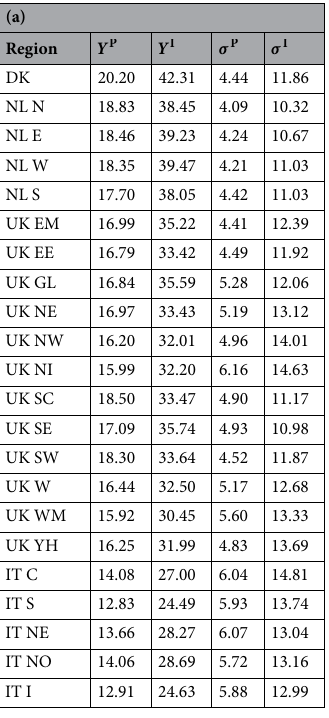
Table 4. Validation data: trust in people Y P , trust in institution Y I and the corresponding standard deviations σ P and σ I for each region considered.